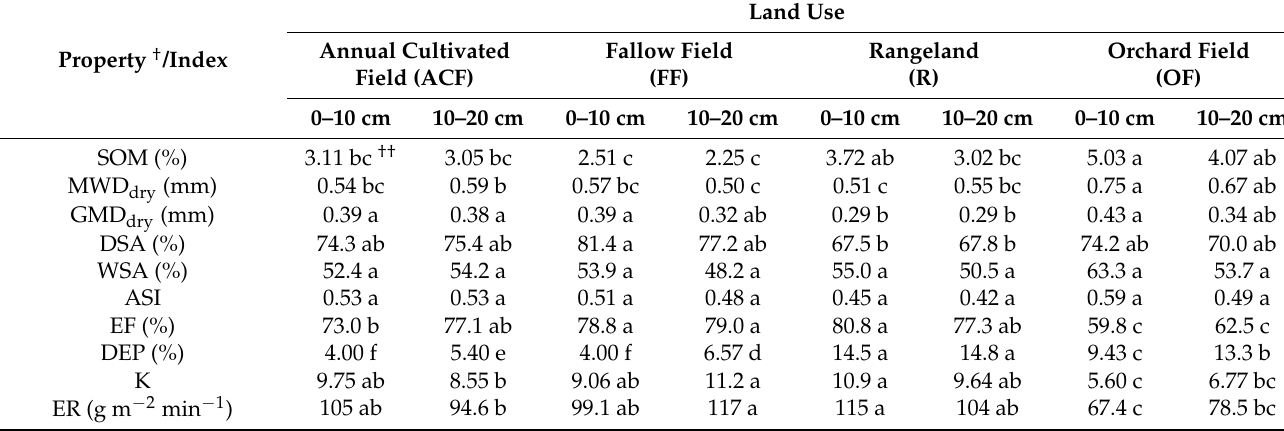
Table 2. Soil organic matter, aggregate stability, and erosion indices of different land-use types at two depths.